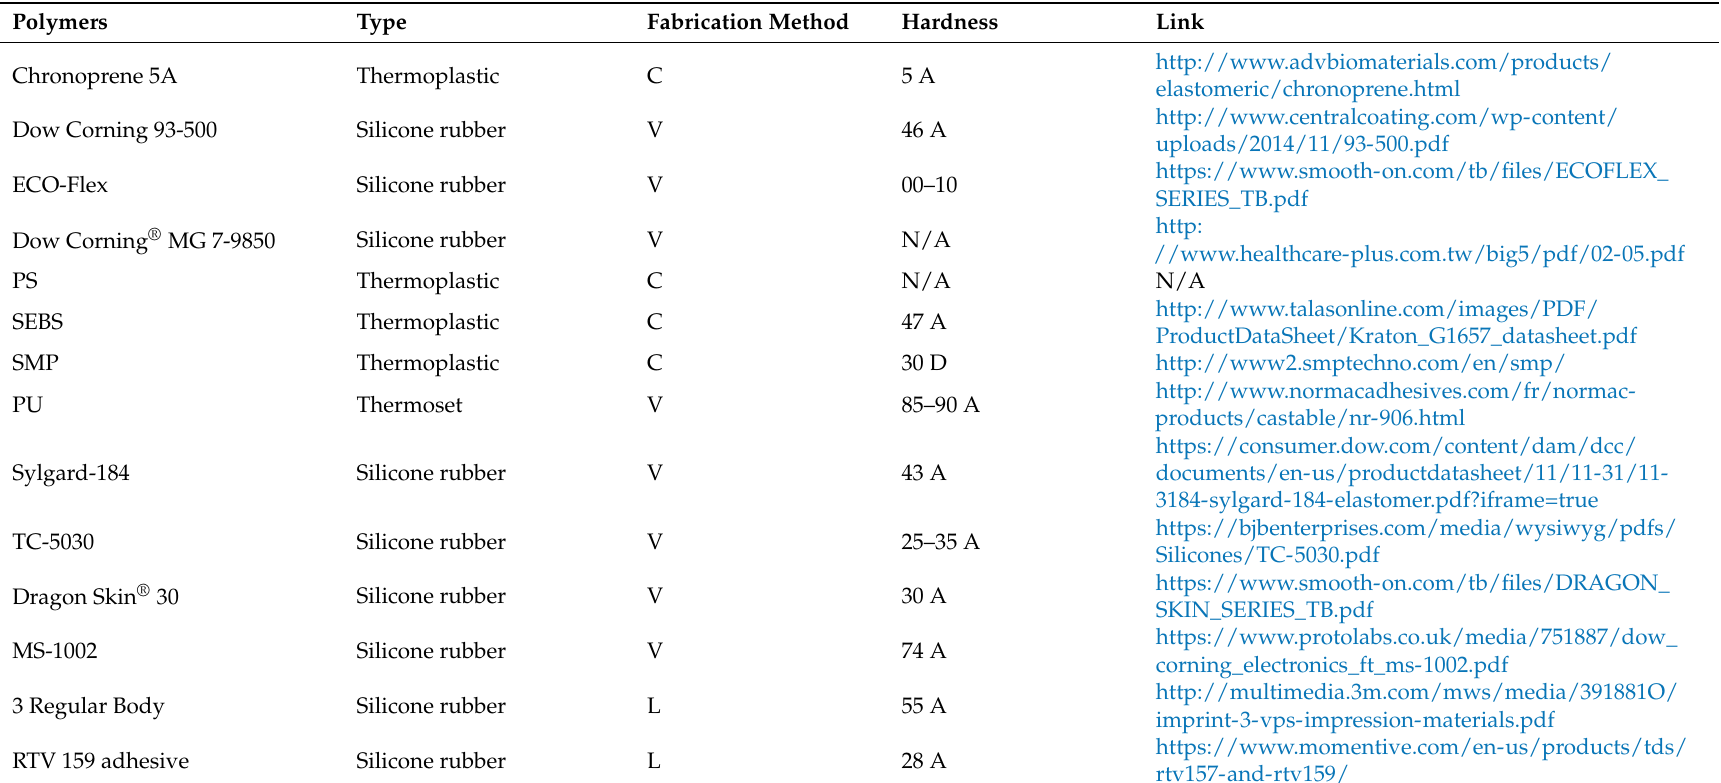
Table 3. Properties of materials used for replicas from fluorosilicone